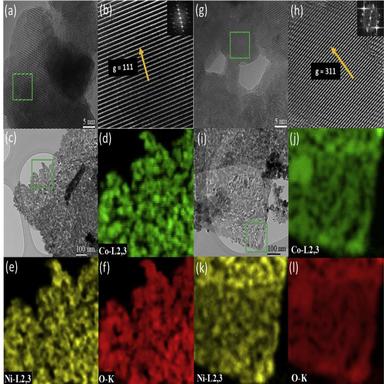
HRTEM micrographs (a and g), zoom-in of the green square area (b and h) (insert: corresponding Fast Fourier Transform (FFT)), TEM micrographs at low magnification (c and i) and corresponding EELS elemental maps of cobalt (d and j), nickel (e and k) and oxygen (f and l) of NiCo2O4eP before (aef) and after the OER reactions (gel) (P stands for PGR).